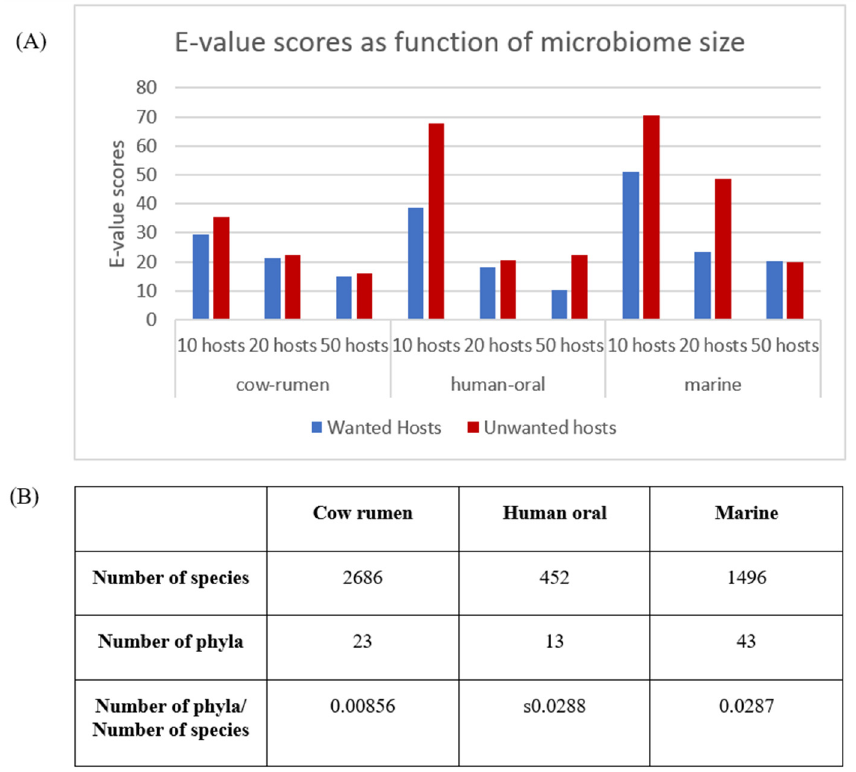
Figure 13. ( A ) E-value scores from a MAST run for a final motif set constructed for randomized MGnify sub-microbiomes of different sizes. The count of wanted and unwanted hosts was set to half the size of the microbiome. Only values from the 5th-percentile of the E-values calculated for the promoters of each host were considered. E-values for each group (wanted/unwanted) were calculated as the median of the median of the values of each host in the group. Test was repeated 10 times for each microbiome size; and ( B ) Meta analysis of MGnify microbiomes.